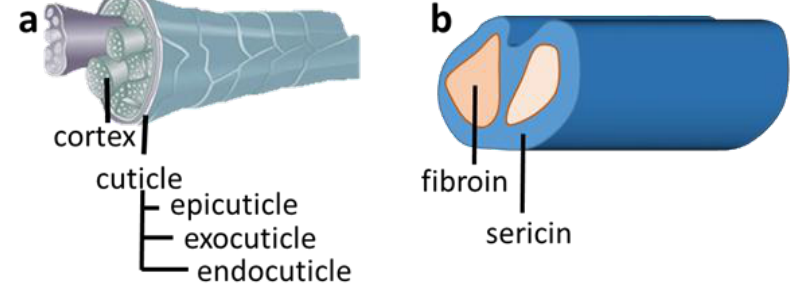
Figure 1. Schematic illustration of the structure of: ( a ) wool fibre [8]; and ( b ) silk